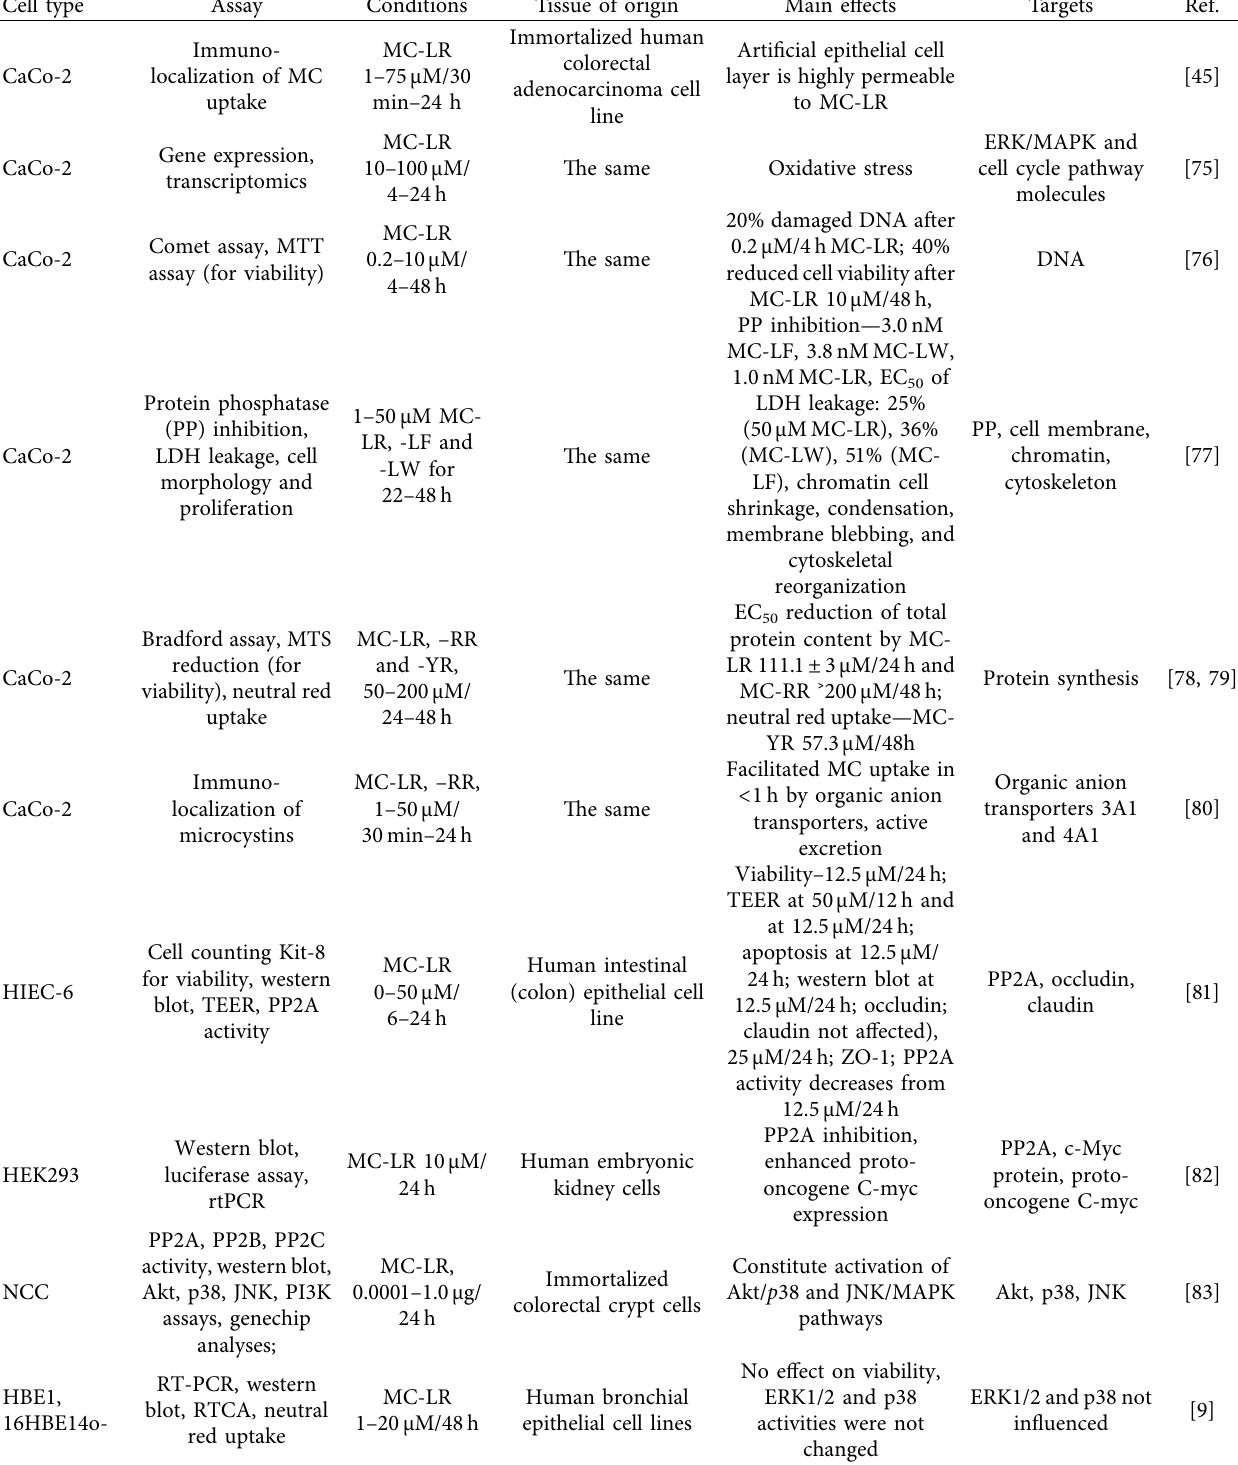
Table 8: Cytotoxicity of